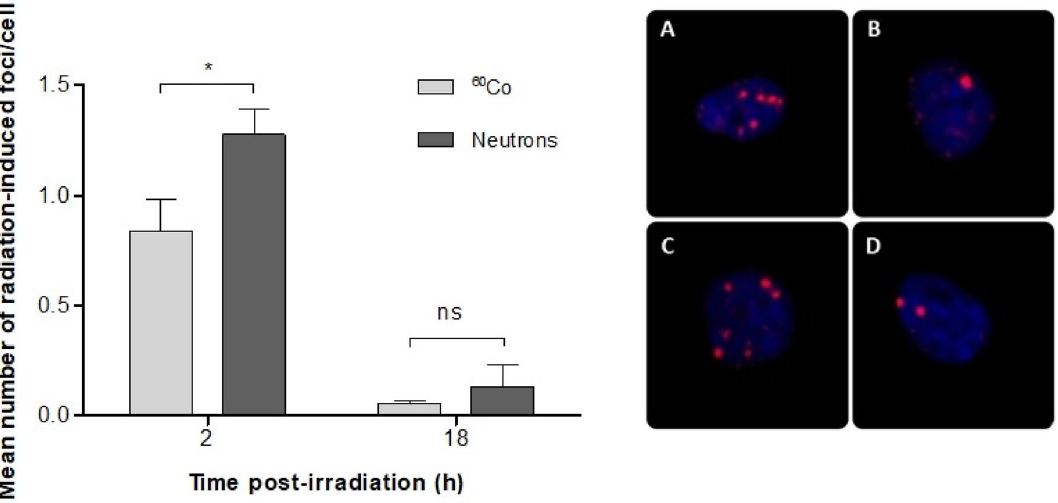
Figure 4. Mean number of radiation-induced γ-H2AX foci per CD34 + cell at 2 and 18 h post-irradiation with 0.5 Gy. The number of radiation-induced γ-H2AX foci was obtained by subtracting the mean number of γ-H2AX foci in the non-irradiated controls from the mean γ-H2AX foci number scored in the irradiated samples. The number of radiation-induced γ-H2AX foci was significantly different between 60 Co γ-rays (n = 6) and neutron (n = 9) radiation at 2 h (* p < 0.05), while after 18 h no significant difference ( p > 0.05) was observed between the two radiation qualities. Error bars represent standard error of the mean (SEM).The images ( A – D ) on the right-side show immunofluorescence staining of γ-H2AX foci with a TRITC-conjugated secondary antibody (red). The foci represent the residual DNA DSBs at 2 h ( A and C ) and 18 h ( B and D ) after 0.5 Gy 60 Co γ-rays ( A and B ) and neutron irradiation ( C and D